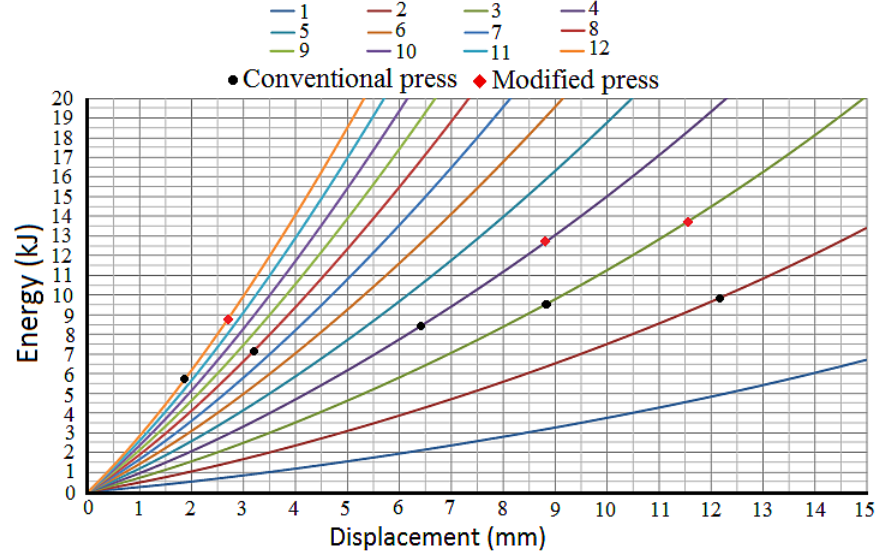
Figure 6. Energy distribution regarding to the degree of deformation for different number of